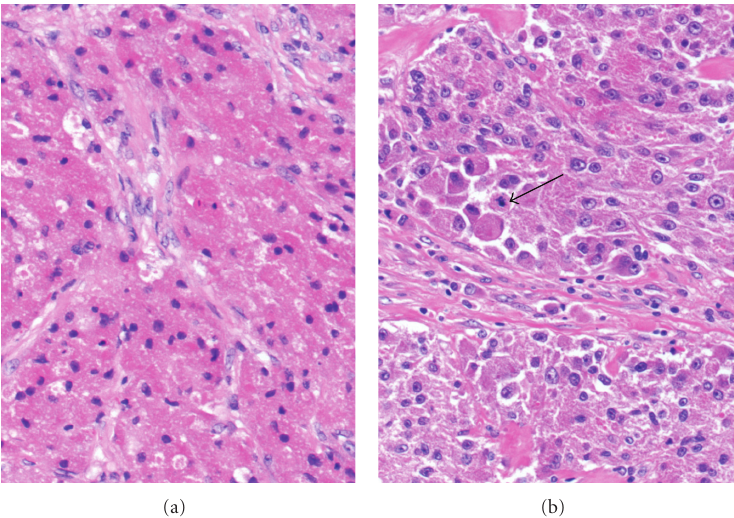
Figure 2: Typical histological appearance of granular cell tumour (a). Sheets of rounded and oval cells with large amount of fine granular eosinophilic cytoplasm. The nuclei are bland and eccentric (20 × , H&E stain). Atypical granular cell tumour (b). In comparison with Figure 2(a), there is nuclear pleomorphism, prominent eosinophilic nucleoli, and cell spindling. A mitosis is also present (arrow) (20 × , H&E